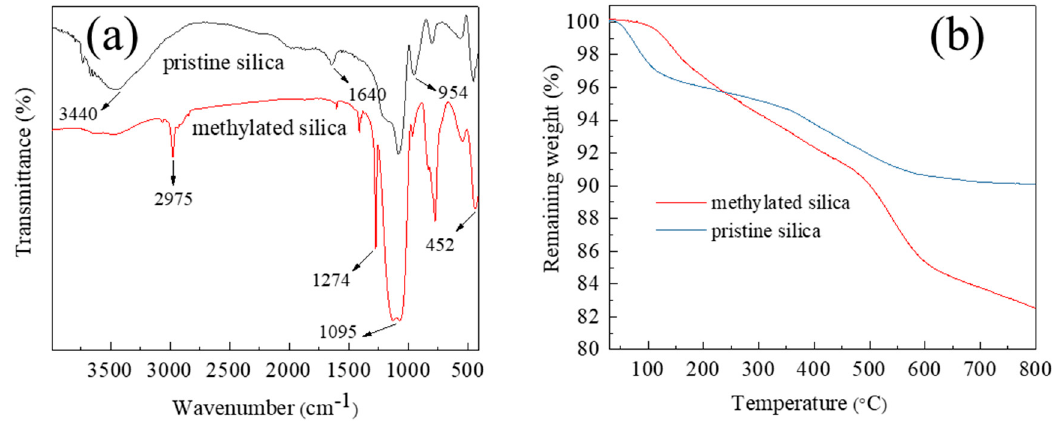
Figure 2. ( a ) FTIR spectra of the pristine and methylated silica. ( b ) Thermogravimetric analysis (TGA) of the pristine and methylated silica.